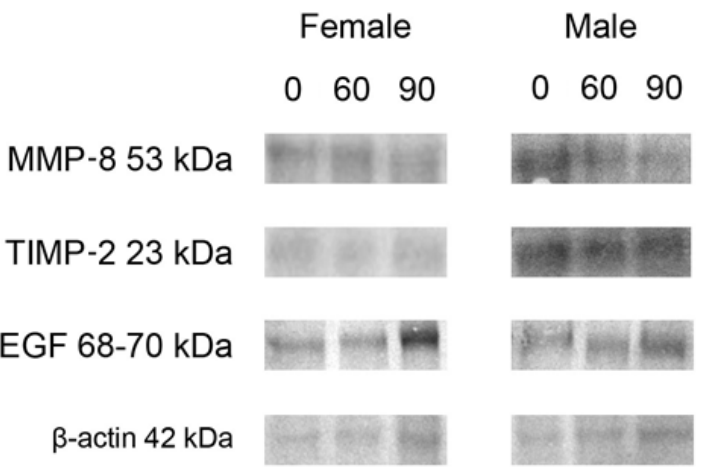
Figure 7. Representative Western blots of MMP-8, TIMP-2 and VEGF as well as β -actin as internal control in femur samples obtained from the newborns prenatally exposed to 0, 60 and 90 mg FB/kg b.w. The relative values of abundance of MMP- 8, TIMP-2 and VEGF expressed as normalized ratio to housekeeping protein β -actin used as a loading control with results of corresponding statistical analysis are presented in Table 4. Original Western blot membranes are presented in Supple- mentary Materials, Figure S4.